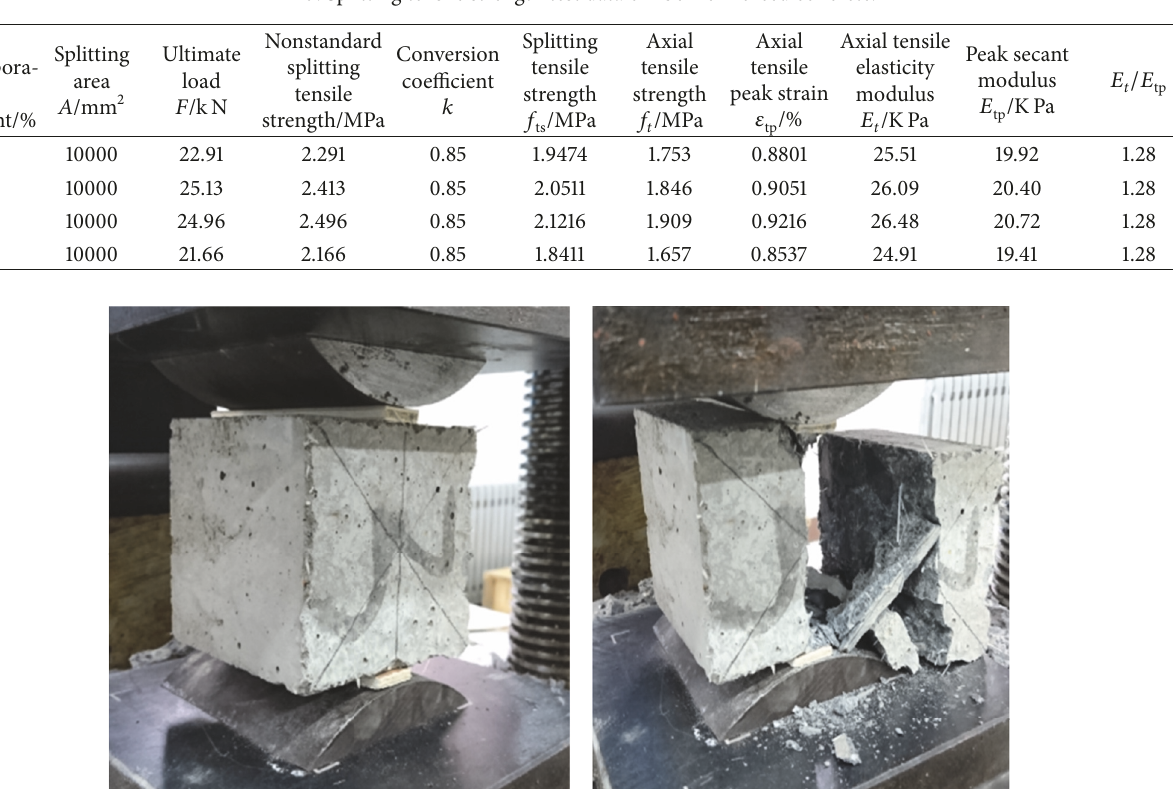
Table 5: Splitting tensile strength test data of fiber reinforced concrete.